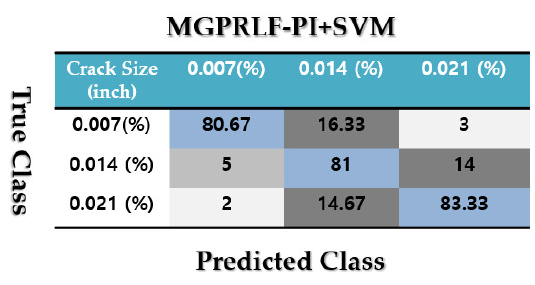
Figure 18. The average accuracies of crack size identification for the RF, IF, and OF using the pro- posed MGPRLF-PI+SVM scheme.